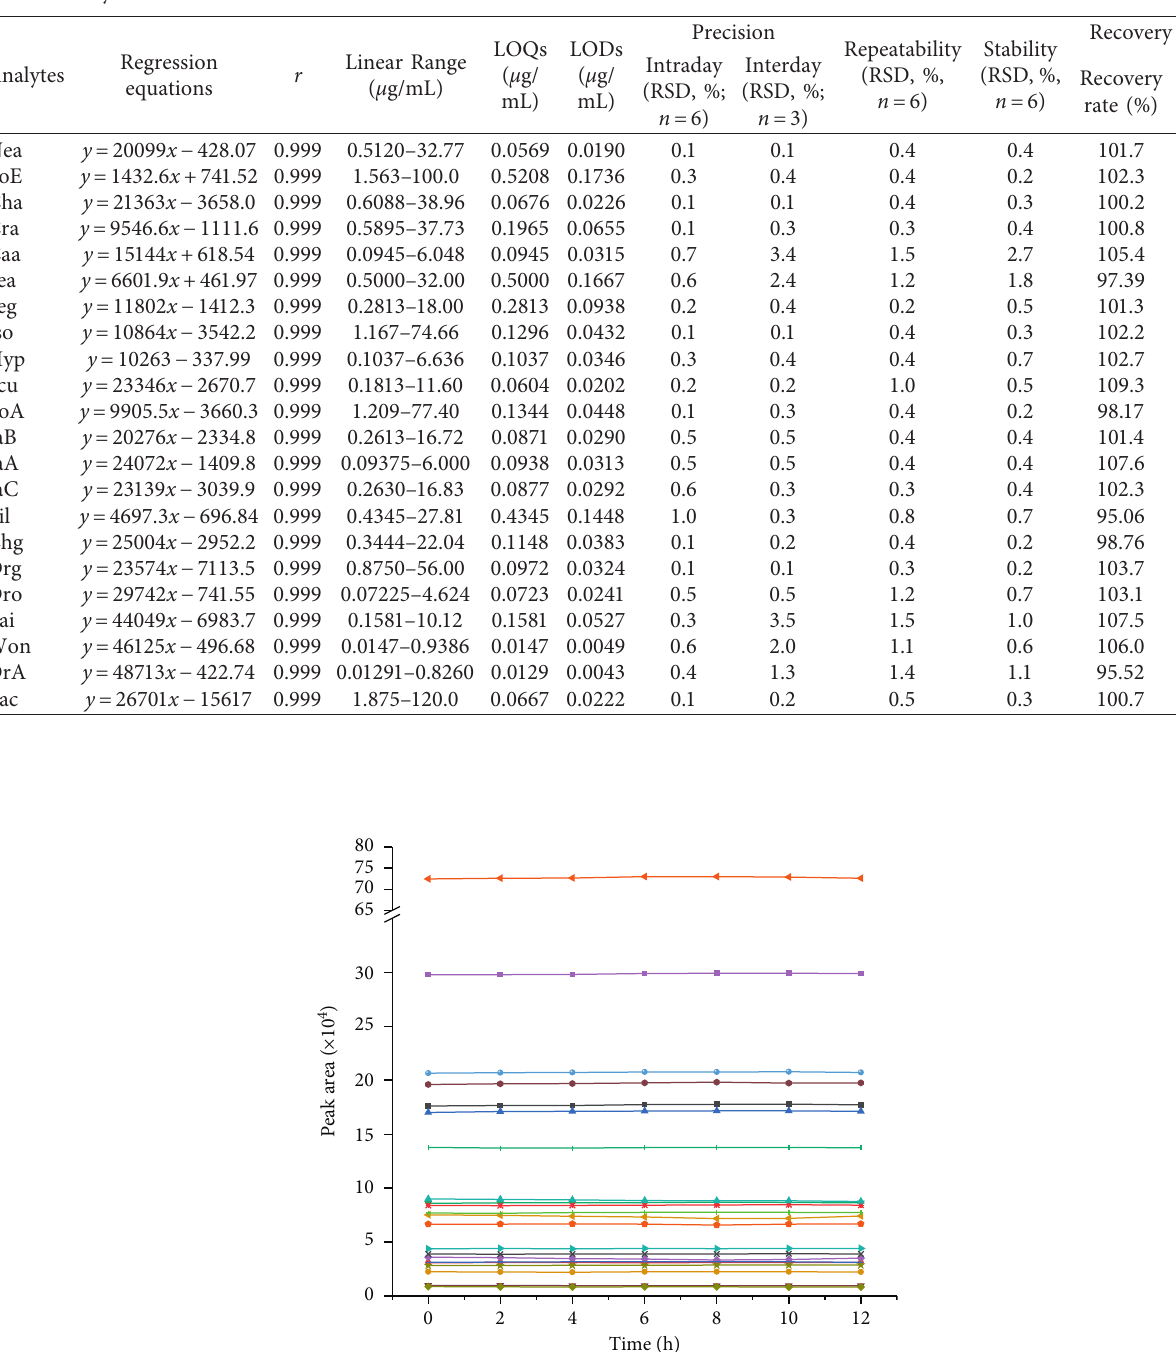
Table 2: Collated results for linearity, LODs, LOQs, intra- and interday precisions, repeatability, stability, and recovery test of the 22 detected analytes in SHLI.